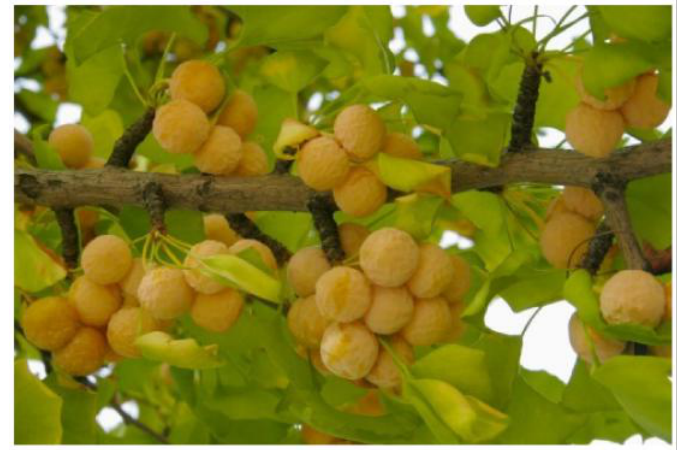
Figure 10. Ginkgo biloba L.